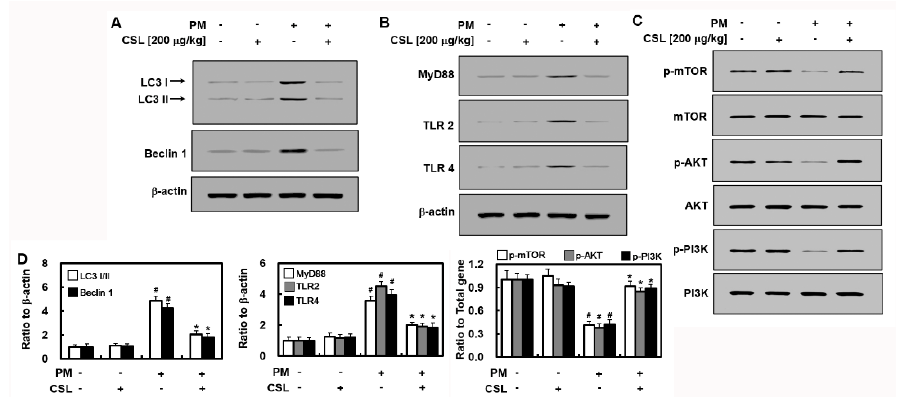
Figure 2. Effects of CSL on PM 2.5 -induced signaling pathways. Representative examples of Western blots showing ( A ) LC3 and Beclin 1, ( B ) Toll-like receptor (TLR) 2, 4, and MyD88, and ( C ) p-mTOR, mTOR, p-Akt, Akt, p-PI3K, and PI3K expression levels. Representative images from each group are shown (n = 3). ( D ) Graphs show densitometric intensities for each gene normalized to that of β-actin or total protein. Values represent the mean ± SD of three independent experiments. * p < 0.01 versus the PM 2.5 -challenged group. # p < 0.01 versus the control group.